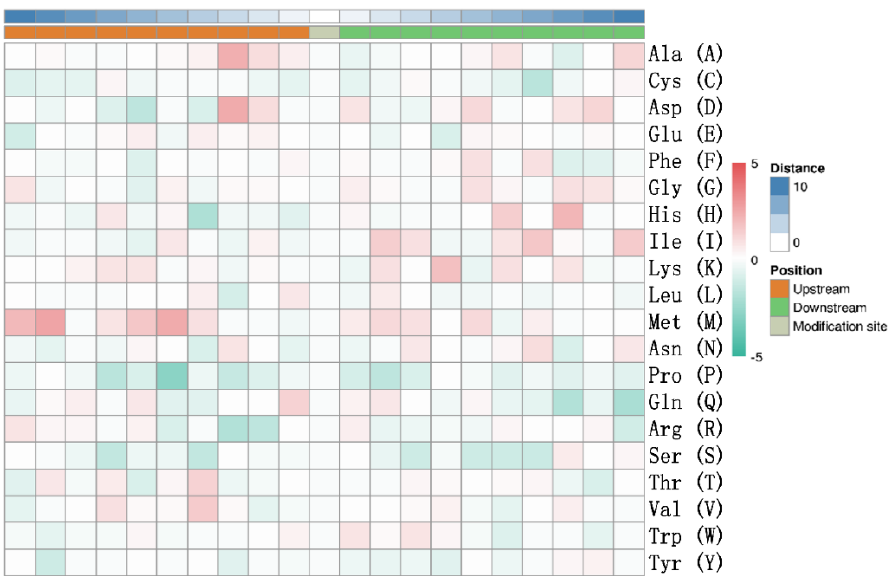
Figure 2. Motif heatmap of upstream and downstream amino acids of all ISGylation sites. Motifs of both upstream and downstream 10 amino acids of ISGylation sites from all identified peptides were analyzed for motif enrichment. The red color represents corresponding amino acids that were significantly enriched at indicated sites, while green color represents corresponding amino acids that were significantly reduced at indicated sites.